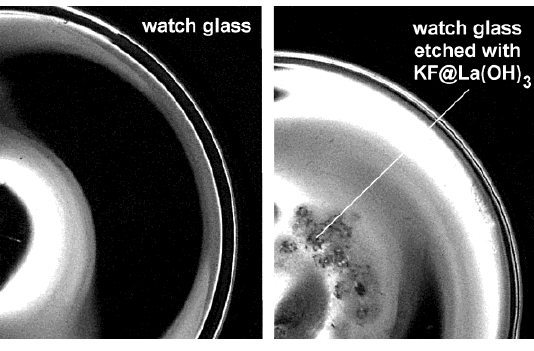
Figure 17. Watch glass prior and subsequent to etching with KF@La(OH) from [56]).